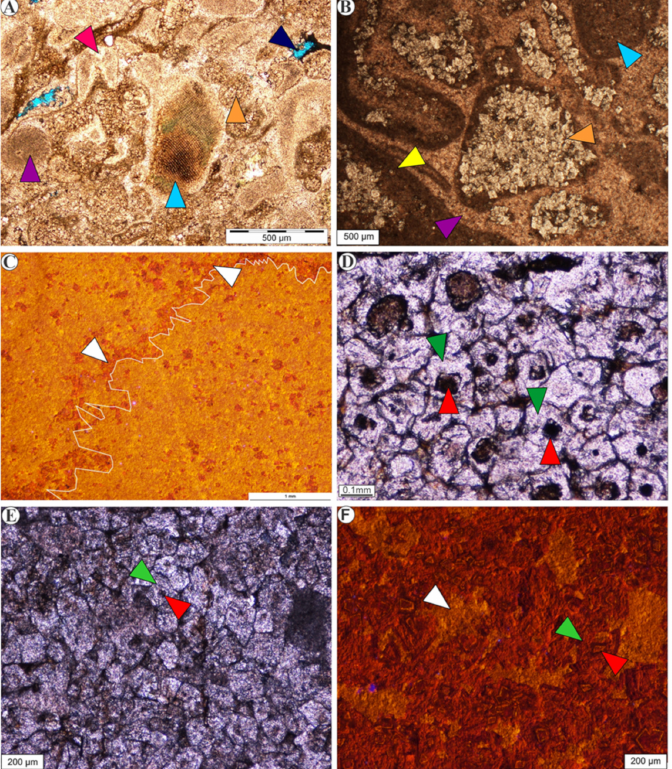
Figure 4. Illustrates ( A ) plain polarized photomicrographs showing partially replaced precursor limestone. Few allochems are completely replaced (pink and orange arrows) by closely packed planar-s to planar-a dolomite crystals, while some of the fossil contents are still unreplaced (blue and pink arrows). Purple arrow points towards the precipitation of sparry calcite cement in the intergranular spaces of studied formation, whereas the dark blue arrow indicate dissolution induced vugs. ( B ) indicates micritization (blue arrow), calcite cementation (purple arrow), partially replaced grains (yellow arrow), completely replaced grain by selective replacive dolomite-RD-I (orange arrow). Section ( C ) illustrates replacive dolomitization (RD-I) along the amplitude of early formed stylolite (white arrow), indicates the conduit nature of the stylolites. ( D ) Two consecutive phases of replacive dolomites (RD-I and RD-II). The RD-I (indicated by red arrows) as a core of RD-II (green arrows) indicates that the first phase of replacive dolomitization was immediately followed by neomorphic recrystallization as a second phase of replacive dolomite (RD-II). ( E , F ) Two phases of replacive dolomites (RD-I and RD-II). Red arrow indicates RD-I and the green arrow indicates RD-II neomorphic recrystallization over the already formed RD-I. CL photomicrograph of both RD-I as a cloudy core and the neomorphic recrystallized RD-II crystal. White arrow indicates calcitization